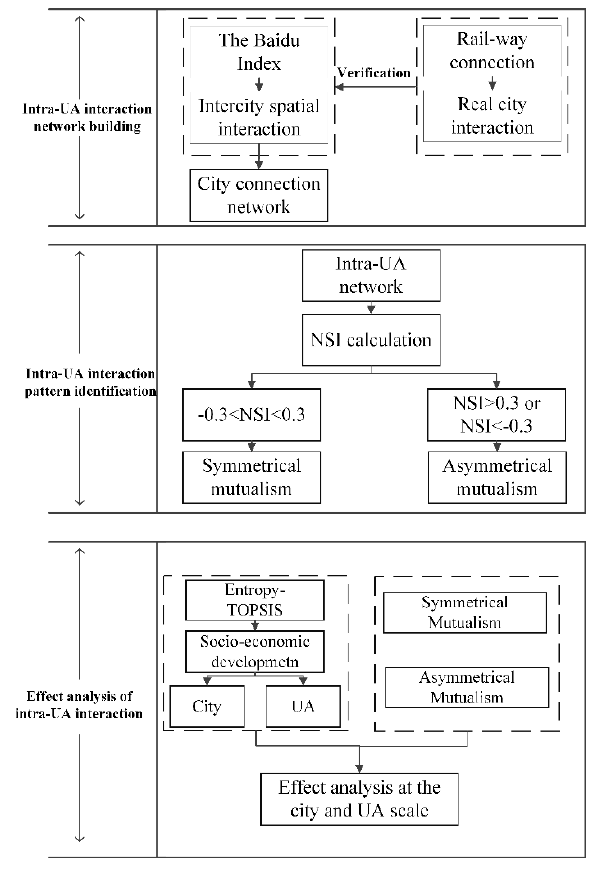
Figure 2. Flowchart of the methodologies.